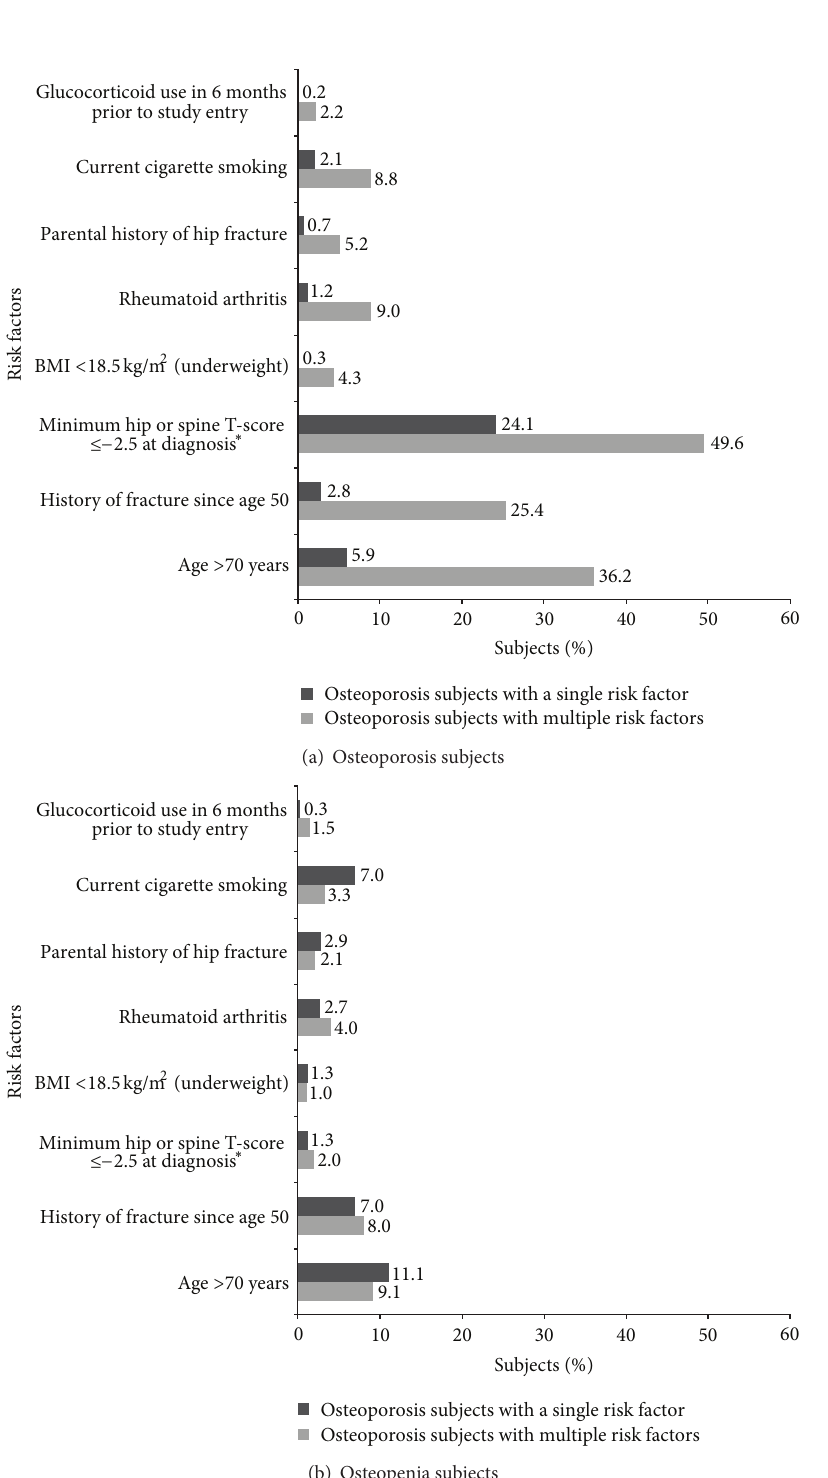
Figure 2: Prevalence of fracture risk factors among subjects with osteoporosis or osteopenia. ∗ Number of subjects with minimum T-scores: 1,703 (88.9%) in osteoporosis subjects; 2,322 (92.4%) in osteopenia subjects. BMI, body mass